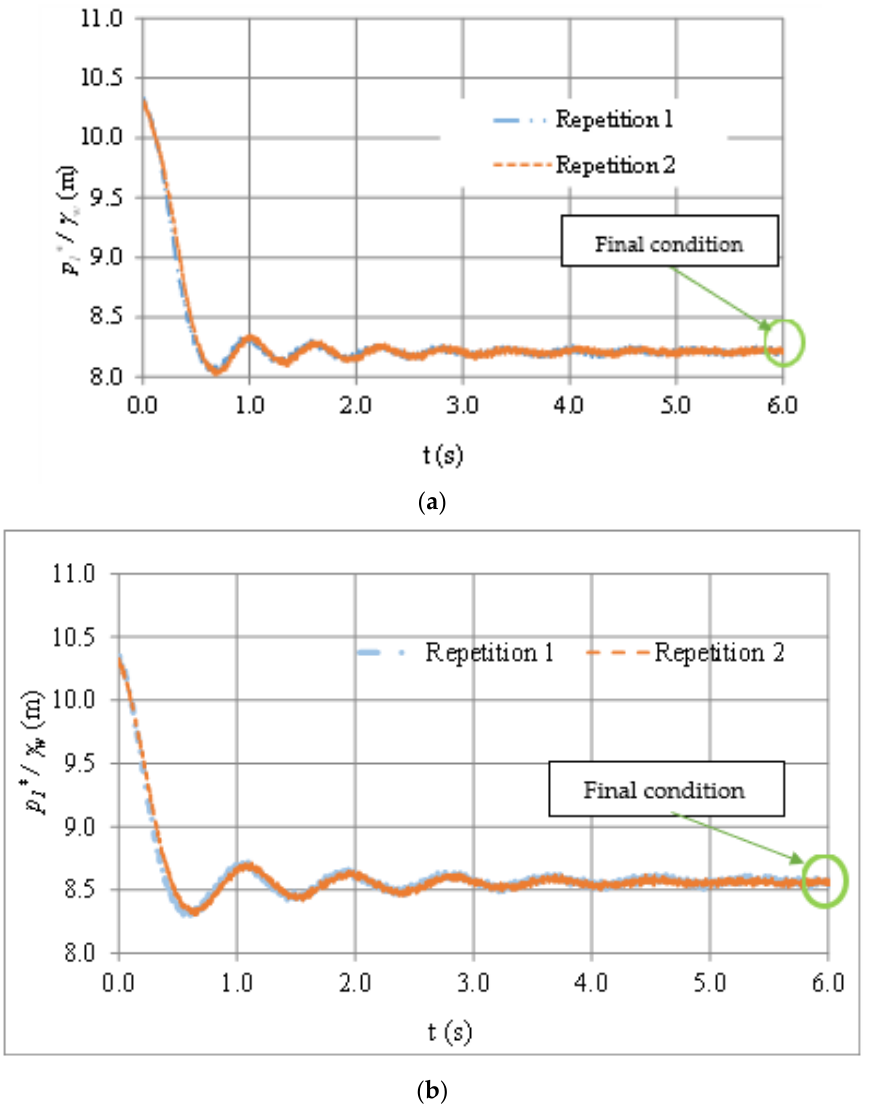
Figure 7. Comparison between measured and computed (final condition) air pocket pressure: ( a ) Test No.1 and ( b ) Test No.2 .